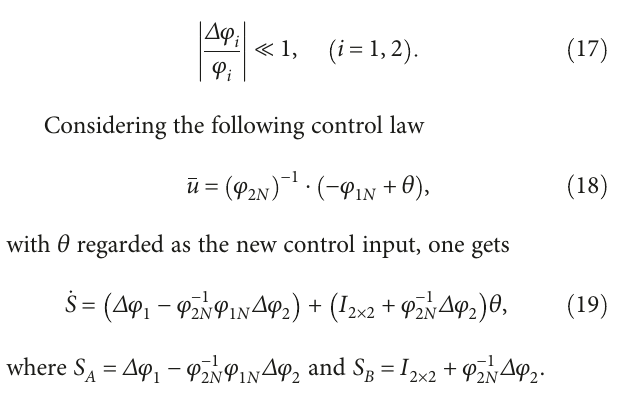
Figure 6: Control scheme of power management of DGEN380 aero engine. Table 2: PI controller parameters of the idle power point.